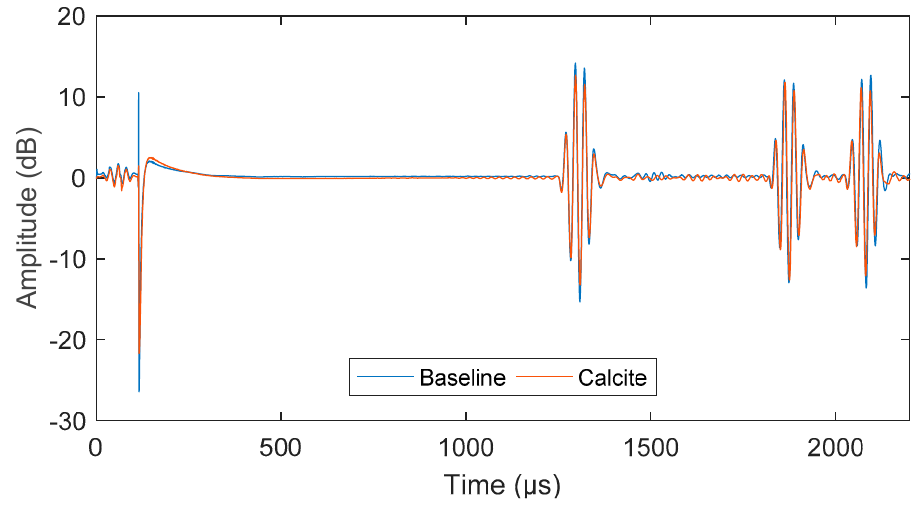
Figure 6. Received UGW signal for baseline and Calcite, displaying drop in amplitude.